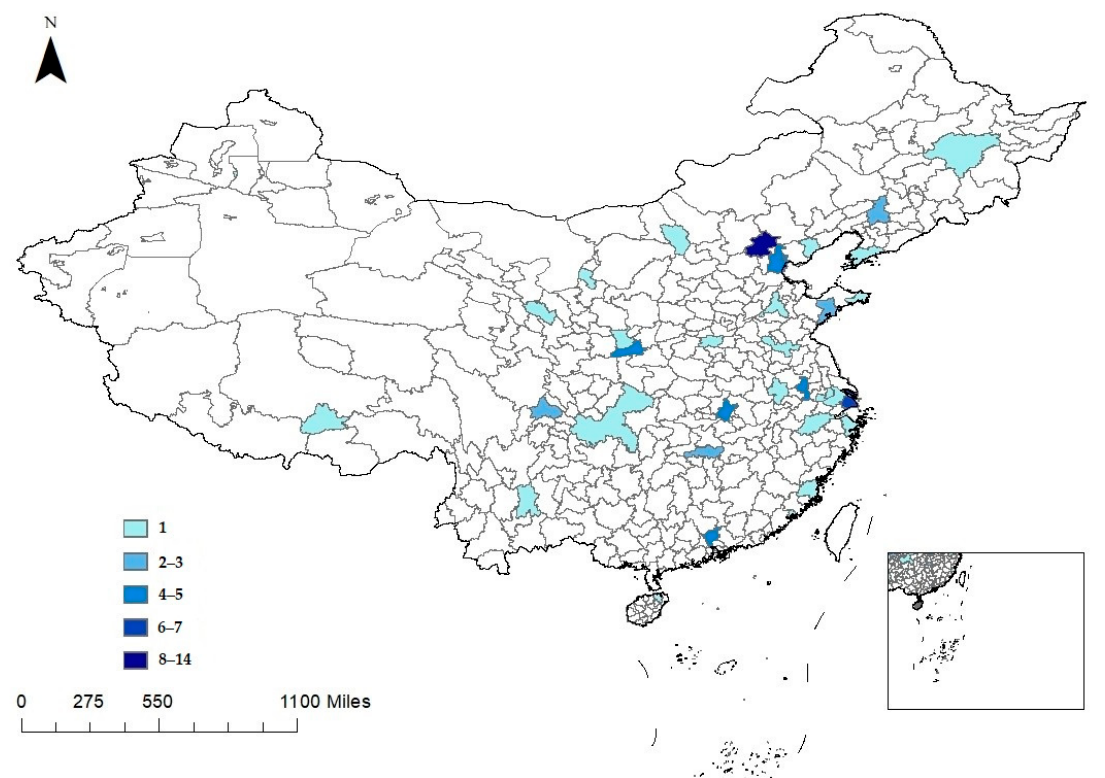
Figure 1. The geographical distribution of the number of double first-class universities.